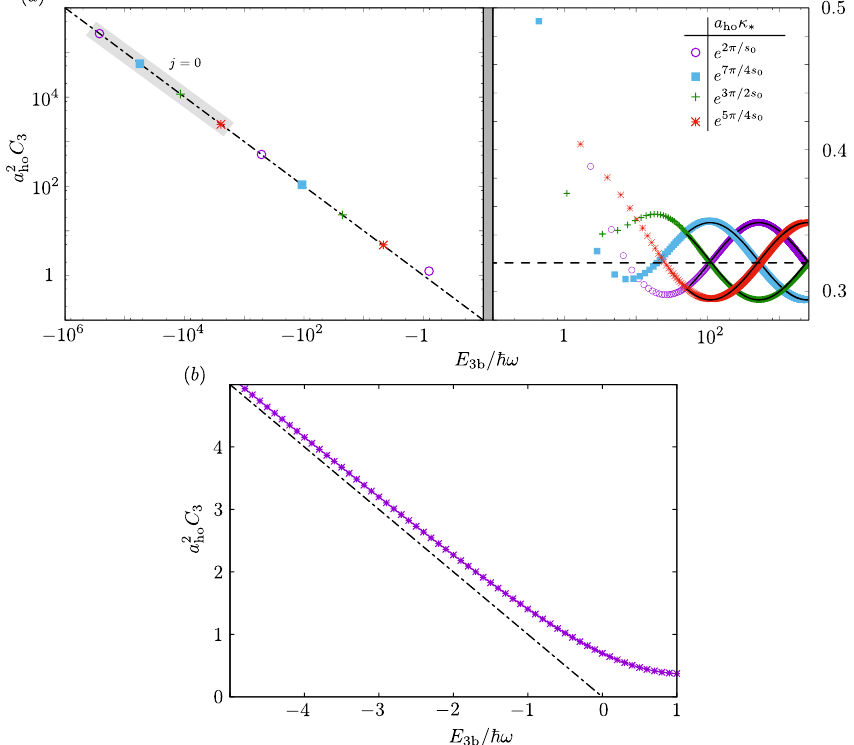
C 3 for both negative and positive eigenenergies in the Efimov channel. Figure 1. Behavior of a 2 ho ( a ) Results for four values of a ho κ ∗ chosen evenly spaced over a single log-period as indicated in the key. The j = 0 indicates the ground-state trimer in the free-space limit in the sense of Equation (12) and are contained in the grey shaded region. The black dashed-dotted line is the asymptotic result C 3 in the limit E 3b /¯ h ω → − ∞ given by Equation (33). The solid black lines are the asymptotic for a 2 ho C 3 in the limit E 3b /¯ h ω → ∞ given by Equation (36) that oscillate around a 2 C 3 ≈ s 0 / π results for a 2 ho ho C 3 given by Equation (30) as a function of indicated by the black dashed line; ( b ) the transition of a 2 ho E 3b /¯ h ω from positive to negative energies. The black dashed-dotted line is the same as in ( a